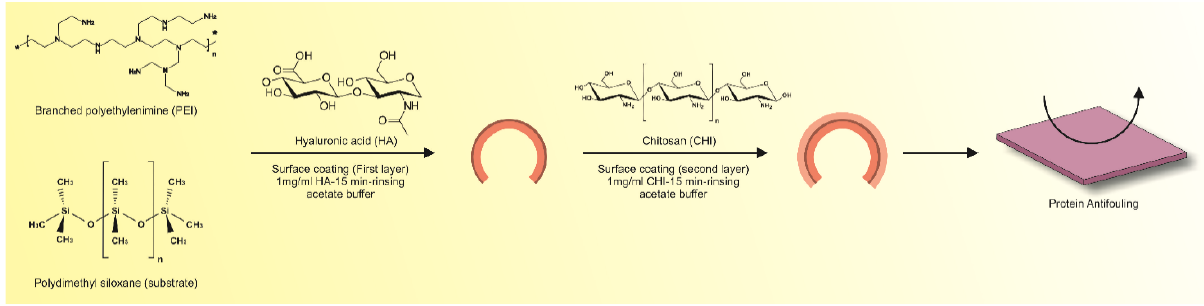
Figure 7. Surface-coated silicone hydrogel with hyaluronic acid/chitosan having protein antifouling characteristics as a contact lens material.